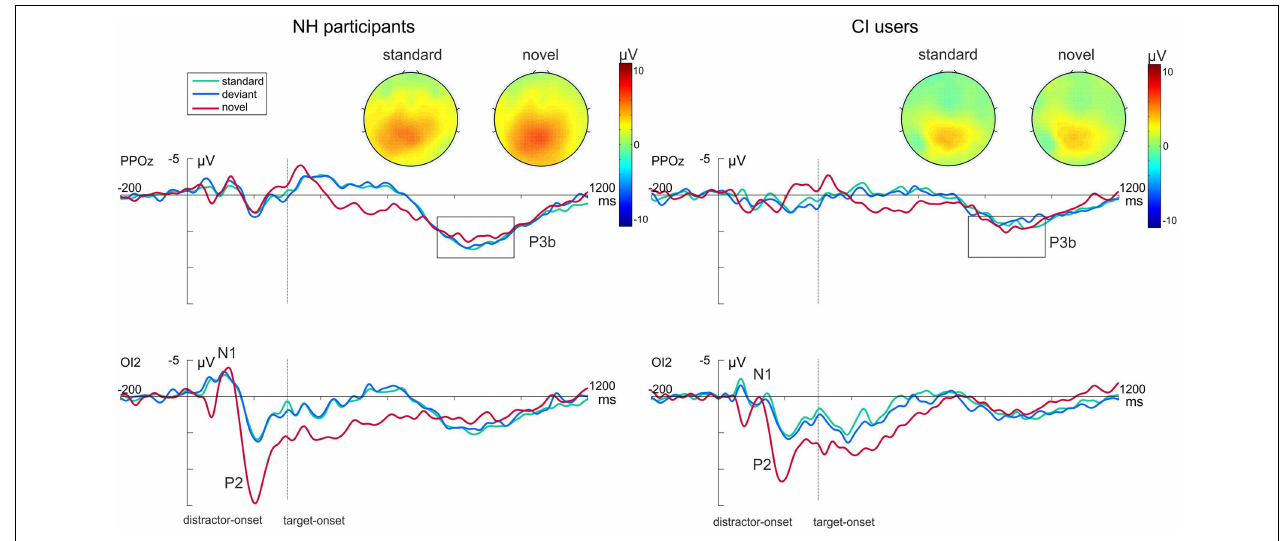
FIGURE 3 | Grand average ERP data for NH participants (left) and CI users (right) in the visual-auditory DFD at PPOz and IO2. Standard trials are marked in green, deviant trials in blue and novel trials in red. Onset of the visual task-relevant stimulus is at 300ms.